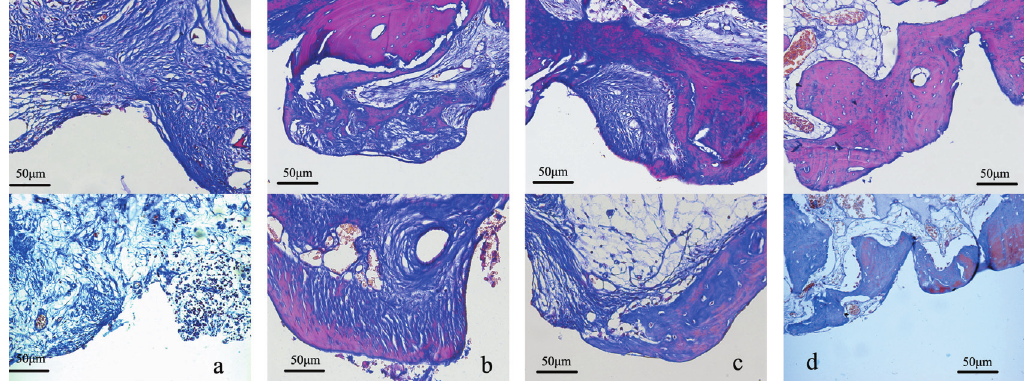
Figure 3- Histologic analysis at the implant-bone interface in the test group (lower panel) and control group (upper panel) using Masson staining. (a) In the test group, a large number of neutrophils were aggregated at the interface at week 1 while a large amount of fibrous tissue was aggregated in the control group. (b) the new bone layer in the test group at week 3. (c) A large-scale dematrix bone (DB) excreted by osteoblasts around the microscrew was observed in both groups at week 8. (d) A mass of mature lamellar bone in the implant-bone interface in both groups at week 12 (Masson stain). Magnification: a, b, c, d;